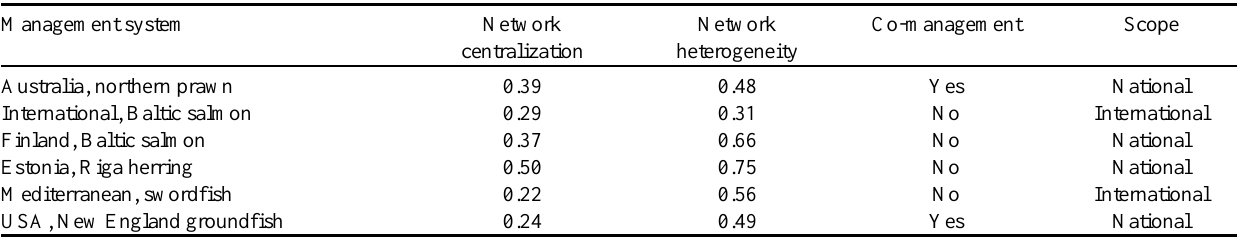
Table 1 . Management systems: